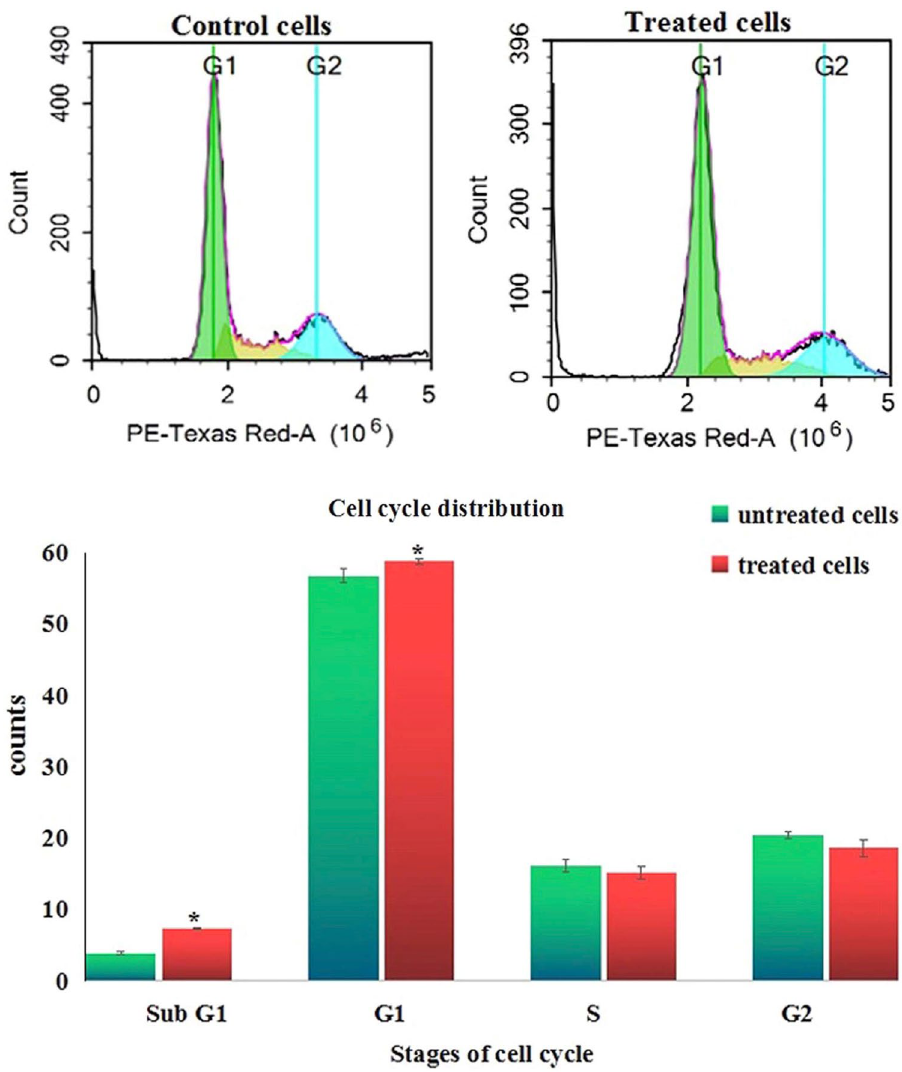
Figure 9. Cell cycle distribution of the control and treated Hep-G2 cells with IC 50 /72 h (6.21 µg/ml) of Erbium Oxide